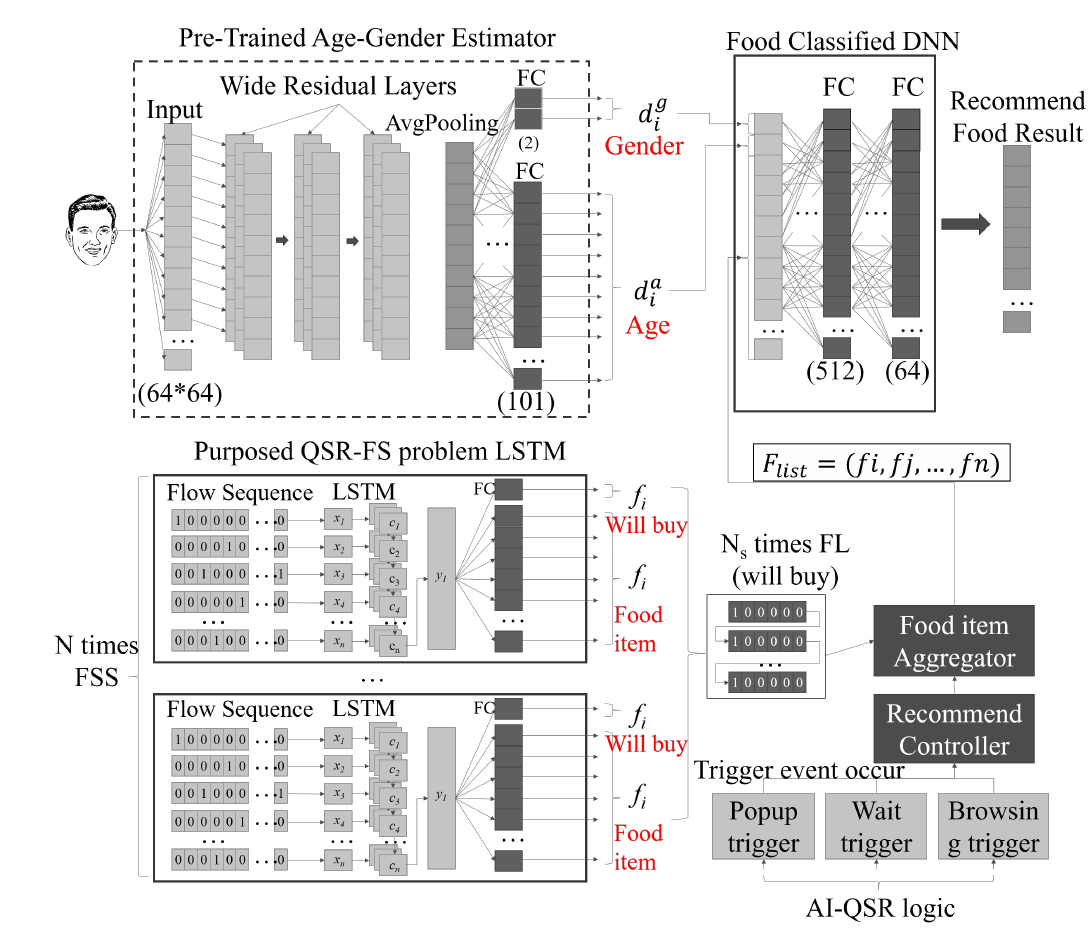
Figure 10. The AI-QSR